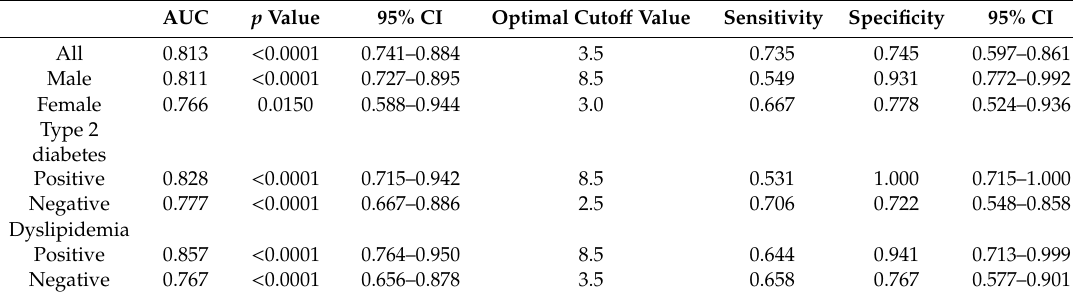
Table 4. The ideal cuto ff values for sTPD from myocardial perfusion imaging correlated with coronary artery disease in di ff erent subgroups of patients using ROC curve